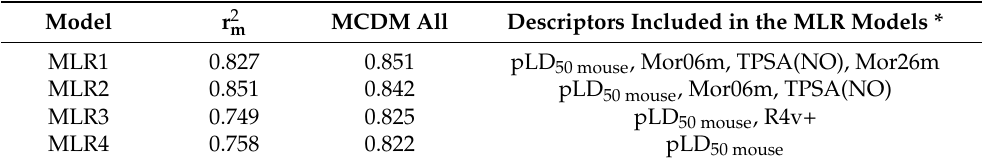
Table 4. The ‘MCDM all’ score values, r 2 m predictivity parameter, and descriptors included in the MLR